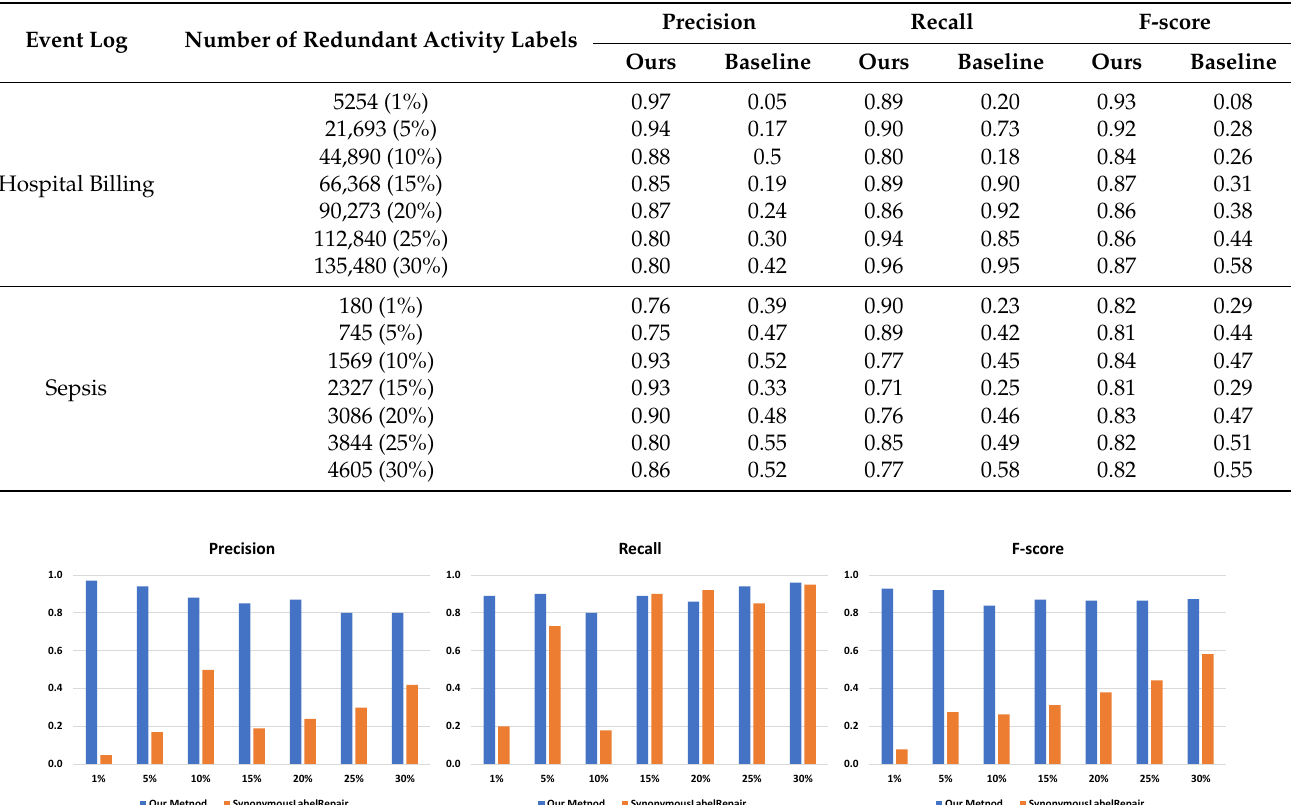
Table 2. Comparison of our framework with SynonymousLabelRepair .